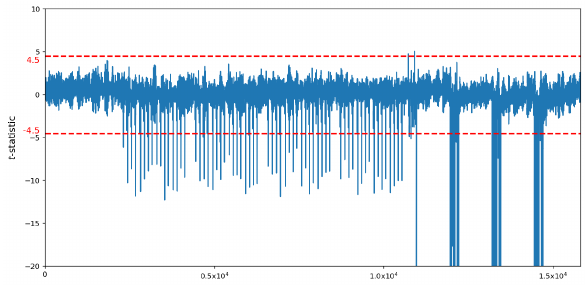
Figure 12: Security order d = 1, parameters are all 1s, random number generator is